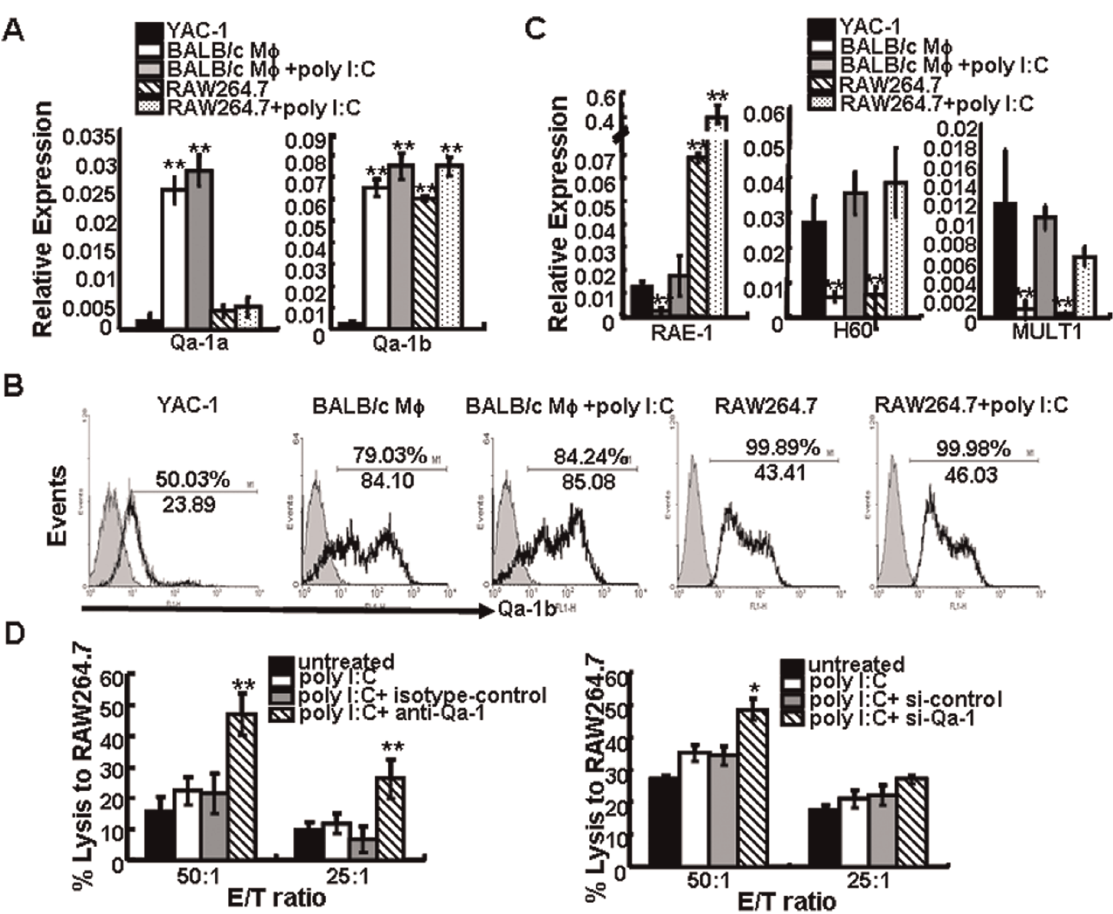
Figure 5. Qa-1 contributes to the protection of macrophages from NK cell-mediated lysis. Changes in mRNA and protein levels of the NKG2A ligands Qa-1a and Qa-1b (A,B), and the NKG2D ligands RAE-1, H60, and MULT-1 (C) in YAC-1 cells, macrophages (M w ) or RAW264.7 cells were detected by RT-PCR or FACS. Data are expressed as relative expression from at least three separate experiments. *p , 0.05, **p , 0.01 versus YAC-1 mRNA levels using the paired Student’s test. RAW264.7 cells first stimulated with 100 m g/ml poly I:C for 24 h and then co-incubated with saturating amounts of anti-Qa-1 mAb or isotype control or transfected with si-Qa-1 or si-control, were then used as target cells. The cytolytic activity of NK cells stimulated with poly I:C-treated macrophages was assessed at various E:T rations (D). Data are expressed as the mean 6 SD from at least three separate experiments. *p , 0.05, **p , 0.01 compared with the isotype control or si-control group.